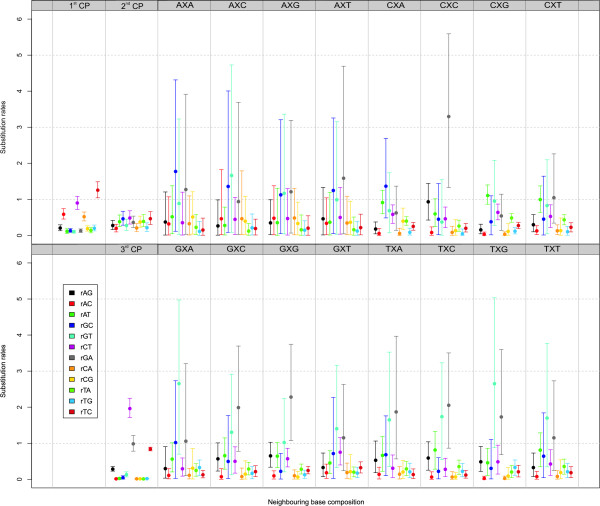
rbcL dataset: Estimated substitution patterns for the independent evolutionary models at first, second and third codon positions and the context-dependent evolutionary model at the third codon position for the GTR123+Γ123+CP123+F123+FF16+3F model. At the left of this figure, i.e. the first two columns, the independent model estimates for first (1st CP), second (2nd CP) and third (3rd CP) codon positions are shown. At the right of the figure (columns 3 through 10), the context-dependent estimates for the third codon position are shown for each evolutionary context, i.e. each neighbouring base combination. In the figure, the substitution parameter types (i.e. rAG, rAC, ..., rTC) each have a unique colour, as indicated in the legend panel within the figure, and the same colour is used for every model (context-dependent or not).